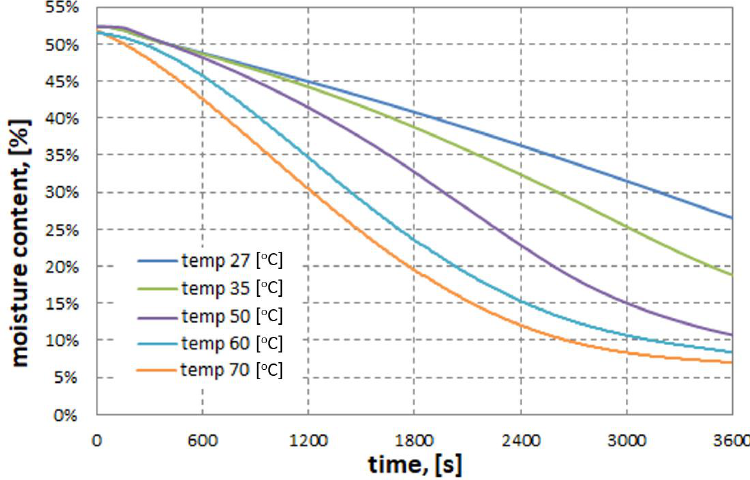
Figure 10. E ff ect of lignite grain size on the drying process at 35 ◦ C for Tur ó w lignite. Figure 10. Effect of lignite grain size on the drying process at 35 °C for Turów lignite.